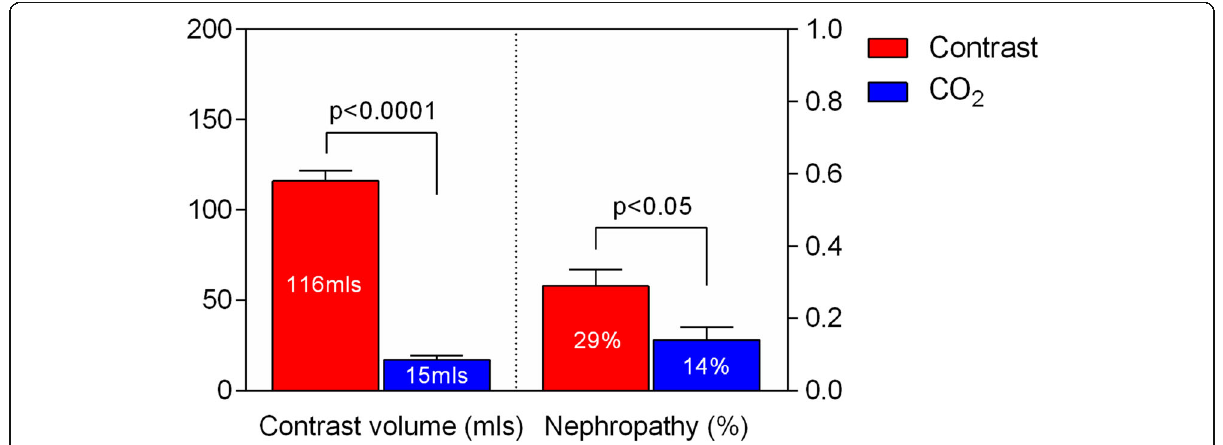
Fig. 1 Total amount of iodinated contrast and incidence of CIN. CO2 (blue bars) and control (red bars) groups